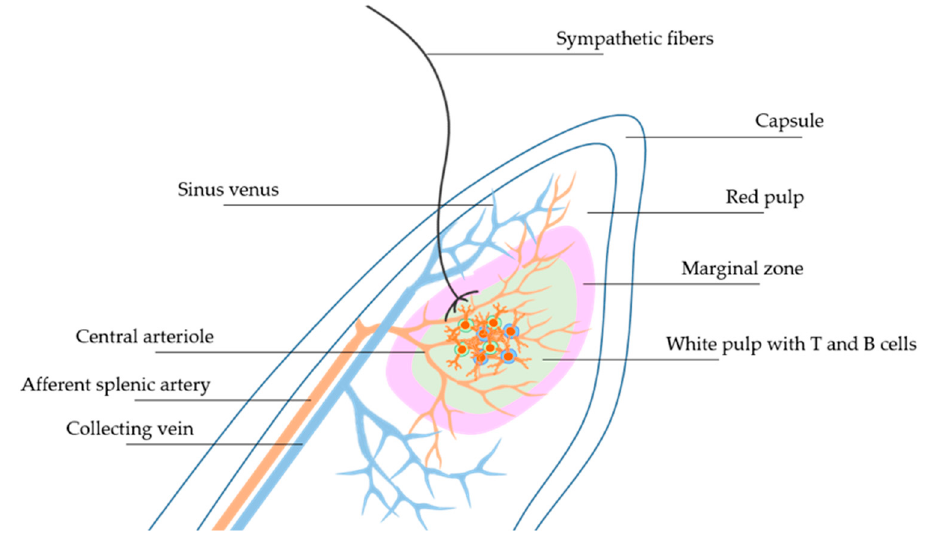
Figure 1. Schematic description of the architectural organization of splenic areas containing various immune cells: White Pulp (WP) and Red Pulp (RP) with Sympathetic nerve fibers innervating Marginal Zones (MZ).